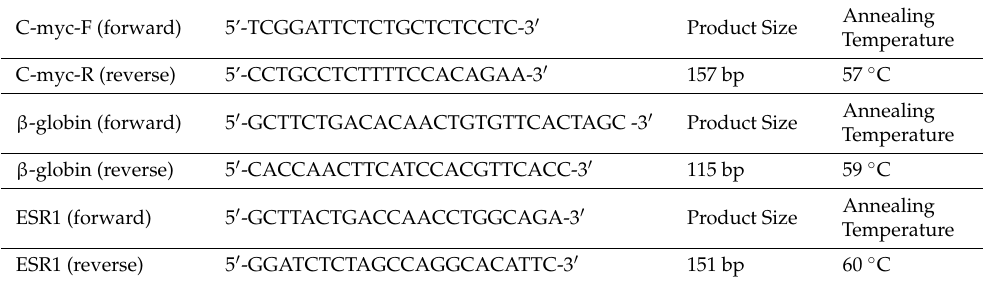
Table 2. Primer details of c-myc, ESR1, and β